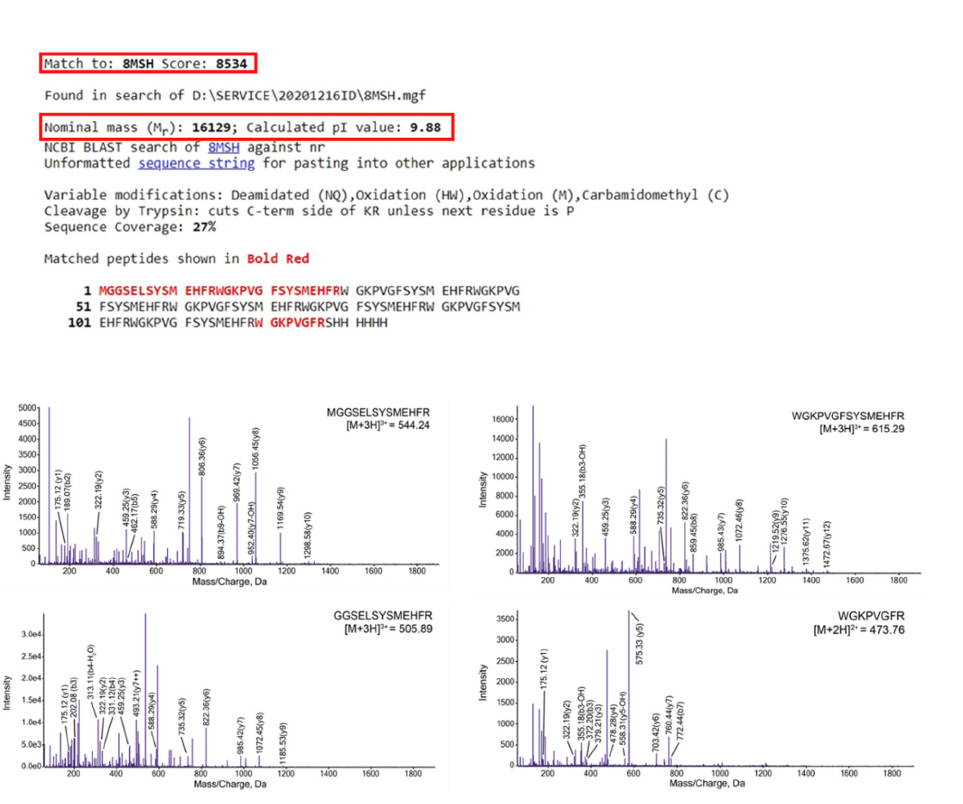
Figure 4. LC-MS/MS analysis demonstrating the identity of 8 α -MSH protein. ( a ) Protein identity fingerprinting of 8 α -MSH using MASCOT. The low sequence coverage (27%) is due to the eight repeats of α -MSH peptide. ( b ) LC-MS/MS spectra demonstrating the identity of the four constituent peptides of trypsin digested 8 α -MSH protein. Table 3. Effect of different intervals for pepsin cleavage of 8 α -MSH.